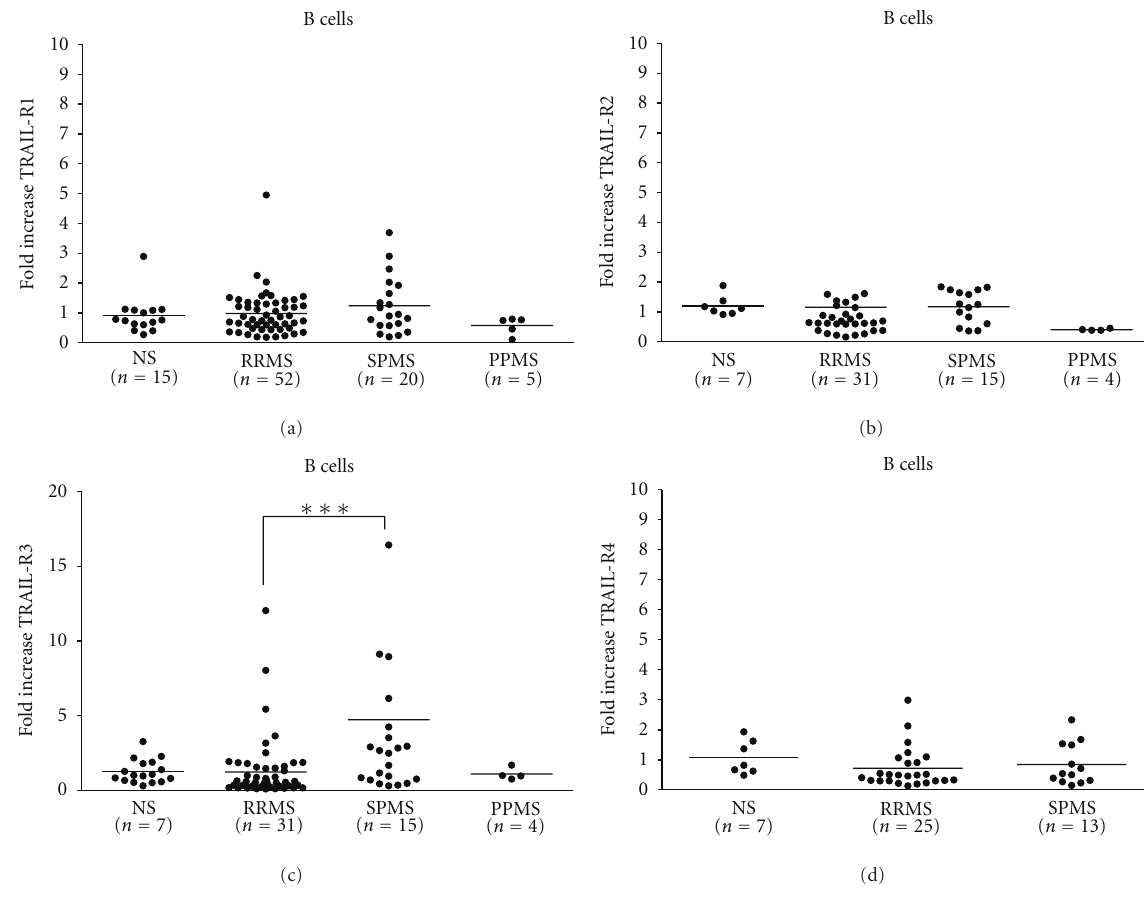
Figure 3: Relative quantification of TRAIL death (TRAIL-R1, TRAIL-R2) and decoy receptor (TRAIL-R3, TRAIL-R4) mRNAs in B cells. (a) TRAIL-R1, (b) TRAIL-R3 and (d) TRAIL-R4 mRNA levels were not altered by IFN- β treatment or di ff erent between the various groups (NS group and MS subtypes). Insu ffi cient amounts of B cell RNA were isolated to permit analysis of TRAIL-R4 levels for PPMS patients. (c) TRAIL-R3 gene expression was increased in SPMS patients irrespective of IFN- β treatment condition (SPMS NO IFN and SPMS IFN groups not di ff erent and therefore pooled) relative to the RRMS group. ∗ P < . 05, Dunn’s post-hoc